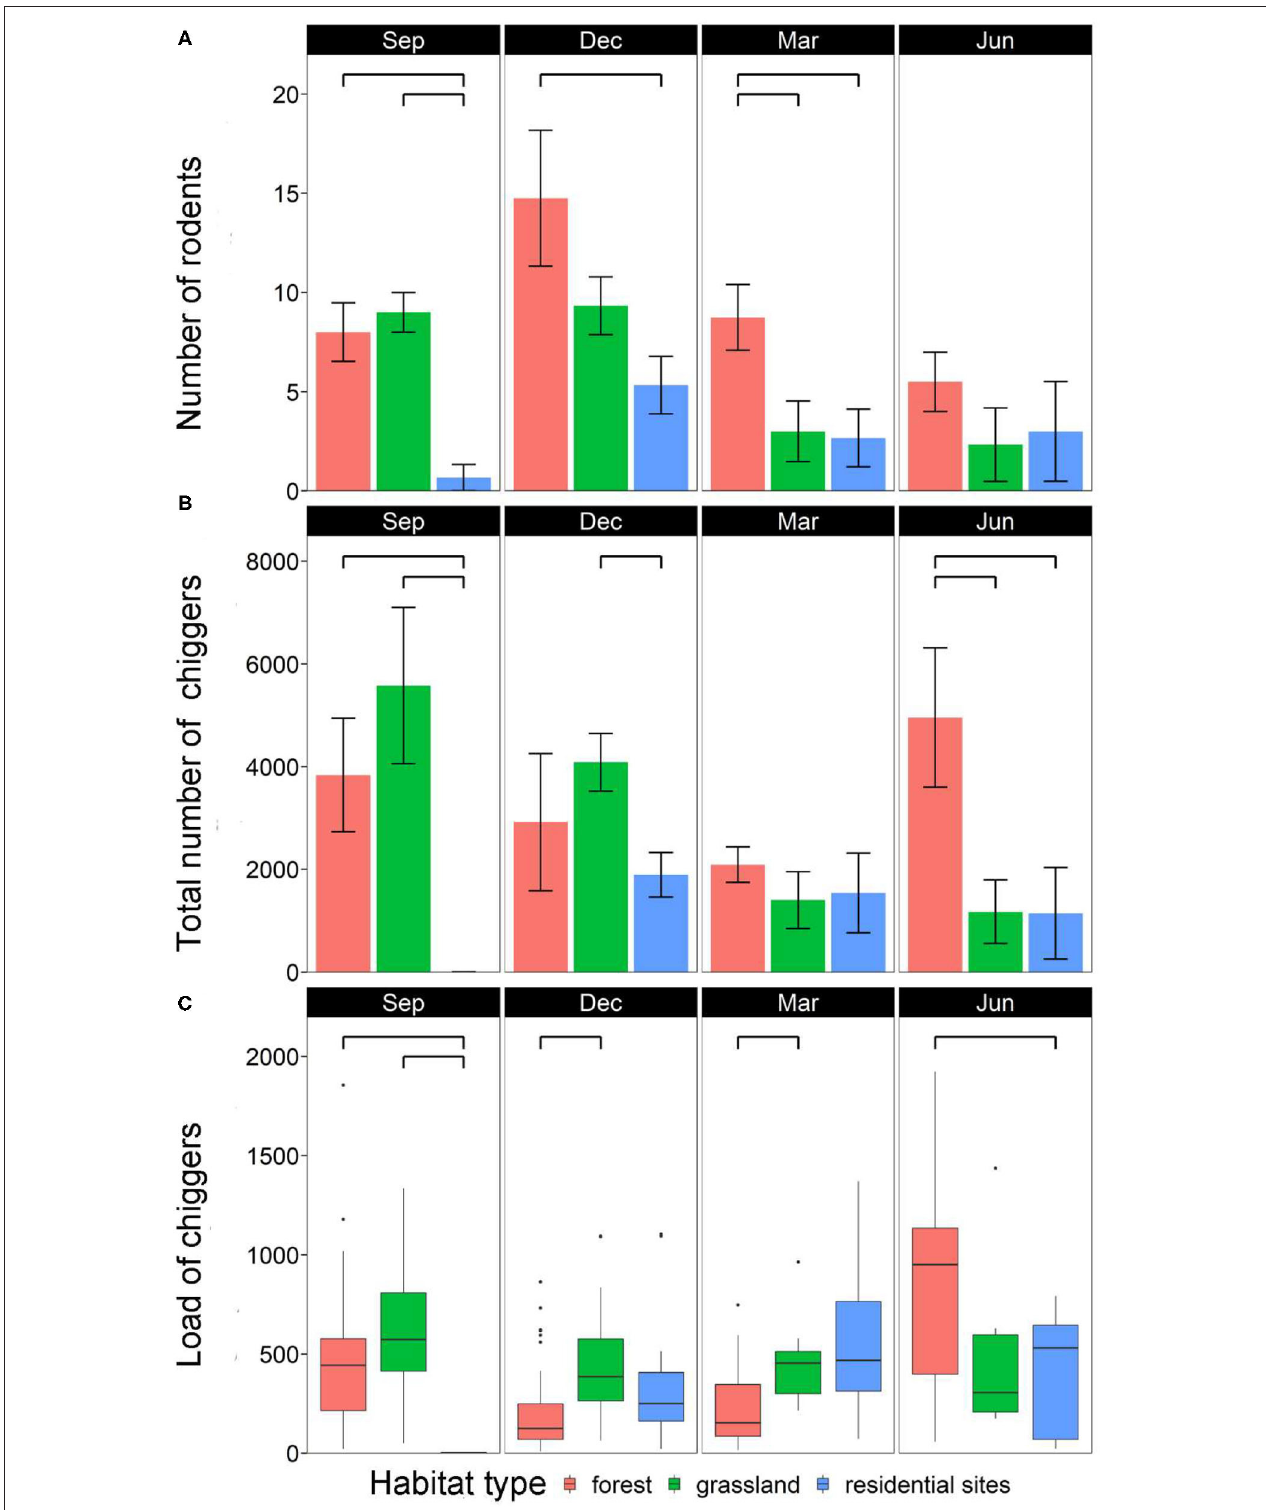
FIGURE 3 | Monthly variations among habitats in (A) mean number of rodents per study site, (B) mean number of total chiggers per study site, and (C) chigger load per rodent individual. Each bar is represented by mean ± SE; significant difference ( p < 0.05) between two groups is annotated with a bridge.